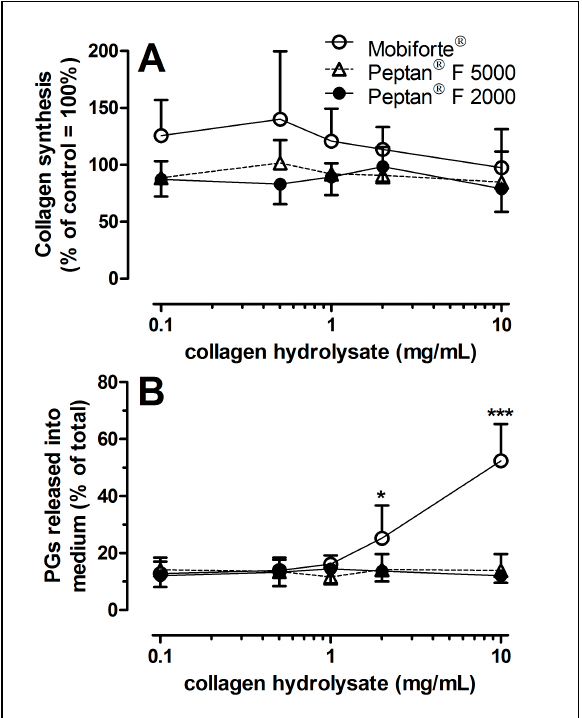
Figure 4. Effect of CHs on collagen synthesis and proteoglycan release from OA cartilage. ( A ) Incorporation of [ 3 H]-proline and [ 14 C]-proline into collagen of human cartilage explants was determined by measuring the radioactivity in hydroxyproline. The [ 14 C/ 3 H] incorporation ratio was then calculated and expressed as the percentage of untreated control (100%) in the presence of 0.1, 0.5, 1, 2 and 10 mg/mL of Mobiforte ® , Peptan ® F 5000 or Peptan ® F 2000. Data are the mean + SD ( n = 4–5); ( B ) Proteoglycan loss from cartilage explants into nutrient media in the presence of various concentrations of CHs was determined during the treatment period, lasting six days. Data were calculated as the percentage of total proteoglycans found in the media and corresponding explants (=100%); data shown are the mean + SD ( n = 6). p -values equal or less than 0.05 were considered statistically significant: * 0.01 < p ≤ 0.05, *** p ≤ 0.001.